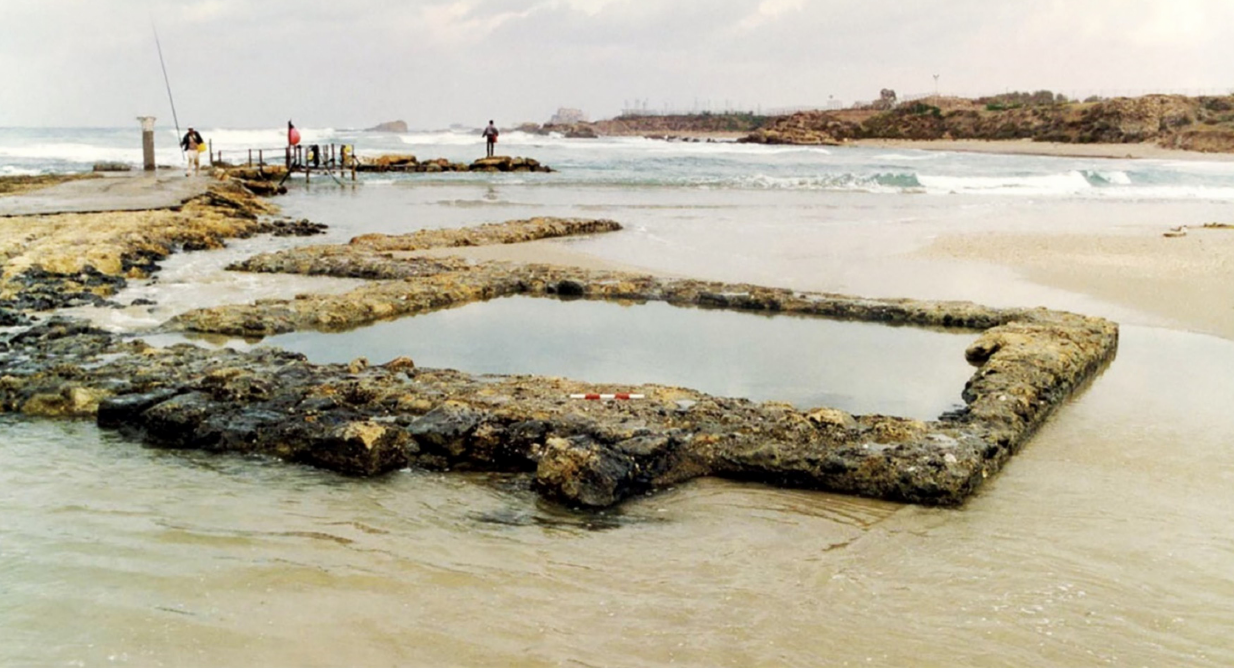
Figure 10. Stone-built pool near Kibbutz Sedot-Yam, looking north-west (for location see Figure 5d)